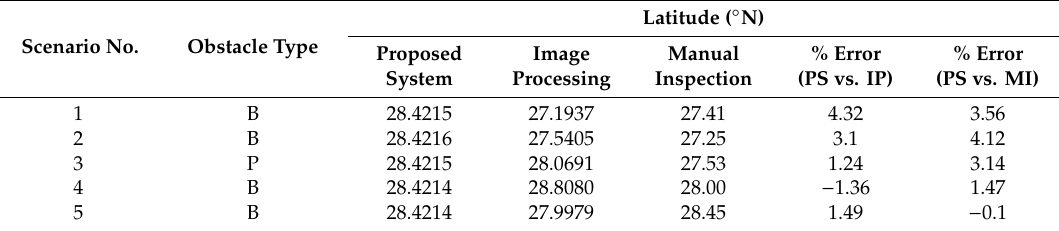
Table 11. Comparison of longitude between the proposed system (PS), image processing (IP), and manual inspection (MI) for the R1 test site.